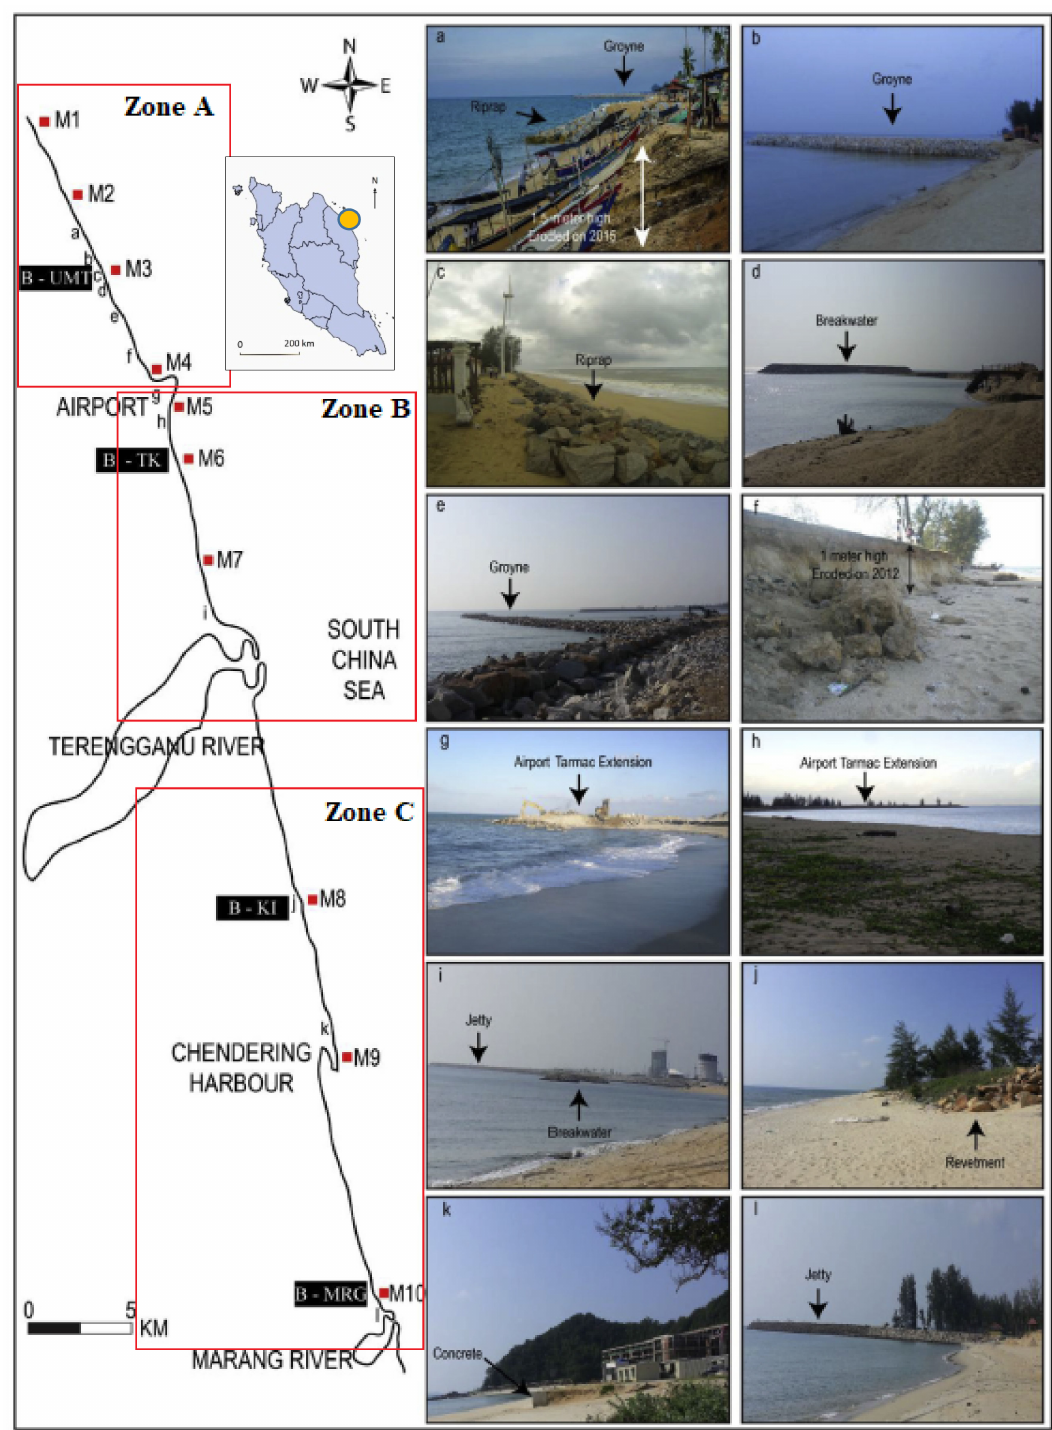
Figure 7. Coastal protection structures along Kuala Terengganu—Marang beach. (Erosion at locations in subfigure a – g , i and j ; accretion at subfigure g , h and l ; no changes at subfigure e and k [82]. ‘Reprinted with permission from [82], 2018; Elsevier. License Number 5071150332416, Date 17 May